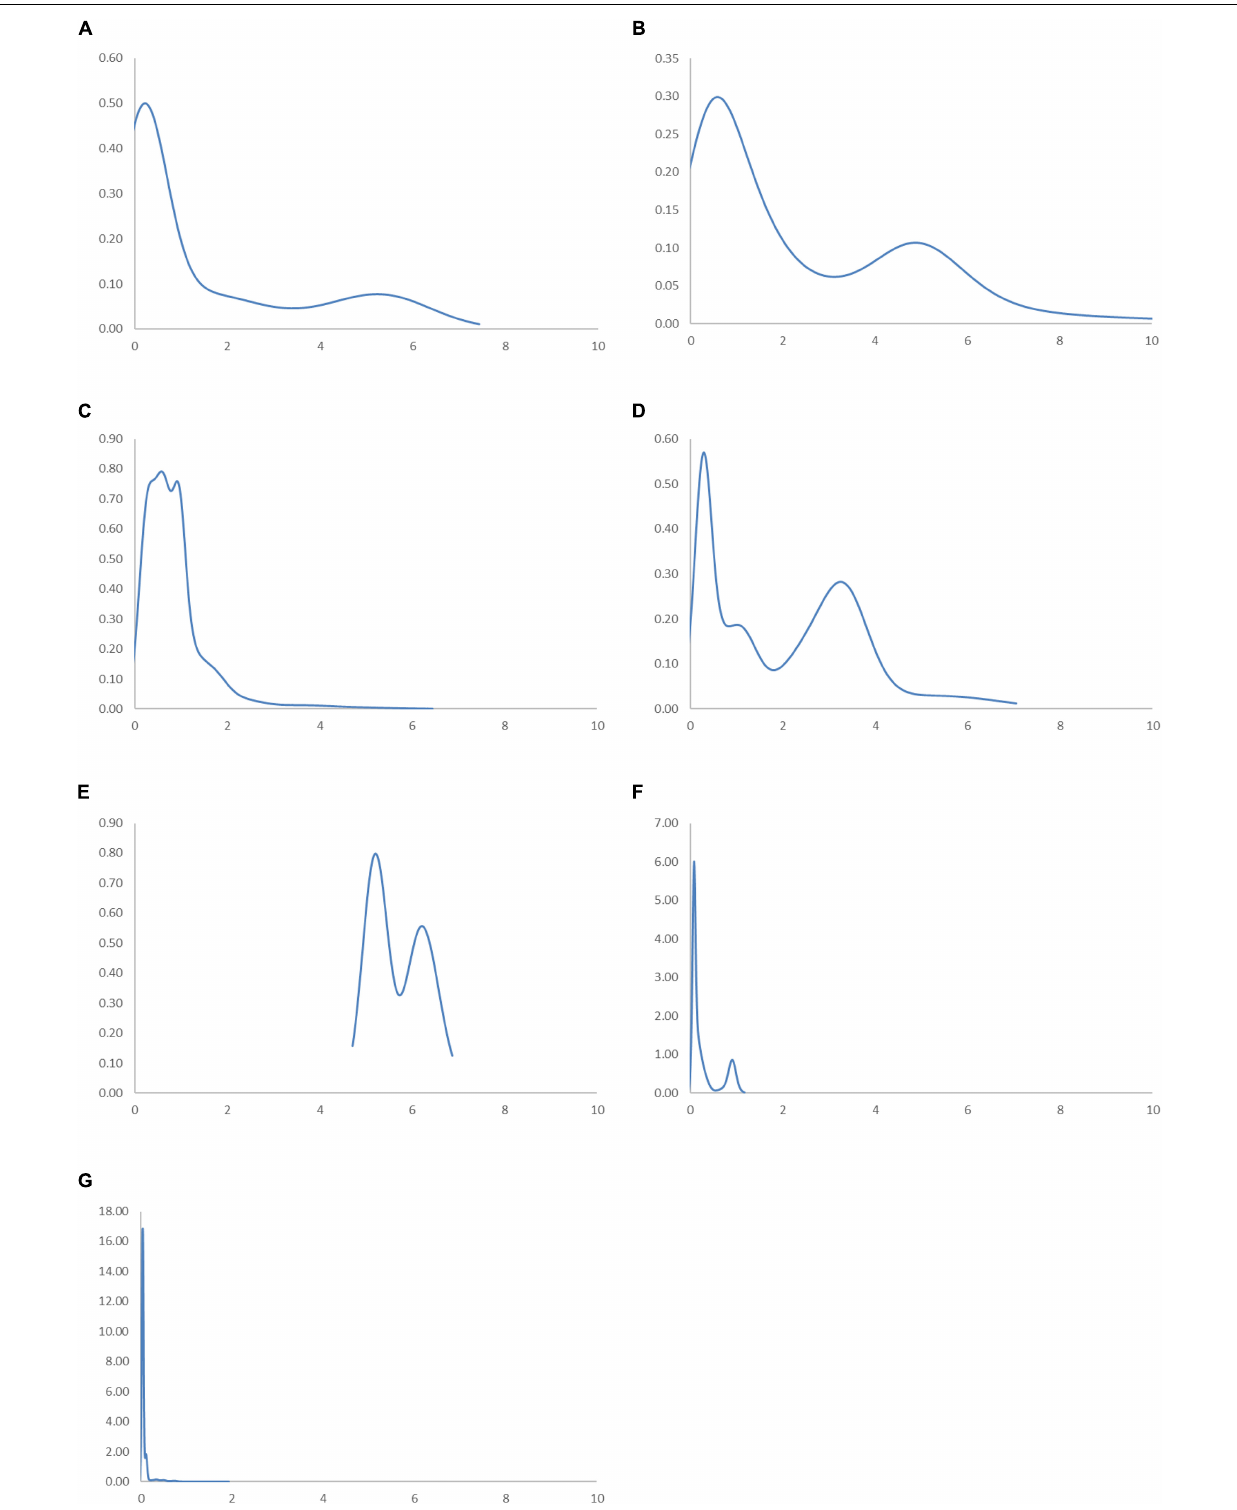
Frontiers in Psychology |